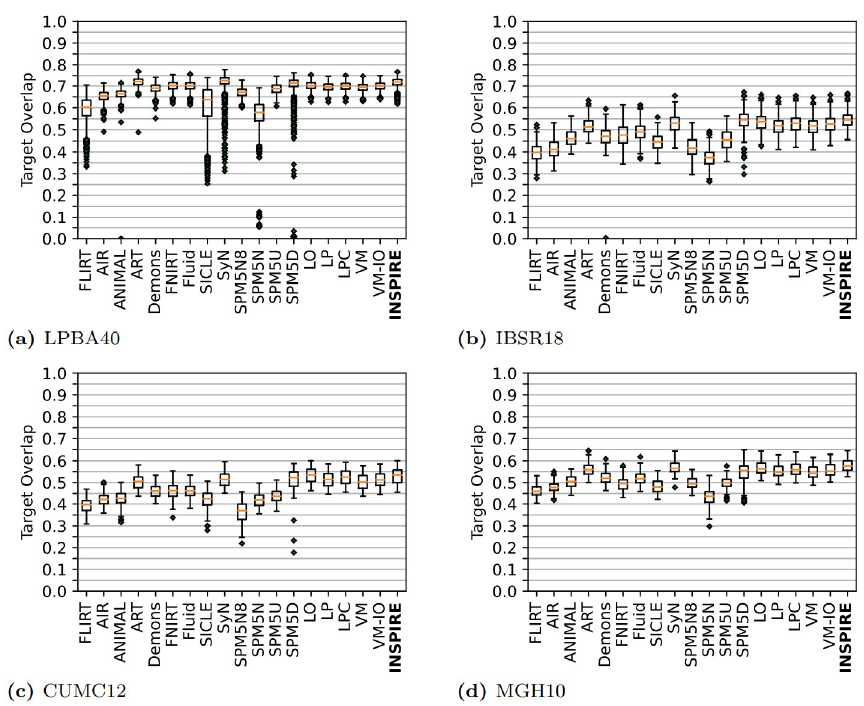
Fig 7. Target overlap (averaged over all labels) shown as box-and-whiskers plots for the four MR datasets. A higher score is better. The center line of the box marks the median, bottom and top mark the first and third quartiles ( Q 1 , Q 3 ), and bottom and top of the whiskers mark the minimum and maximum (excluding outliers beyond Q 1 − 1.5 ( Q 3 − Q 1 ), and Q 3 + 1.5( Q 3 − Q 1 ), which are shown as diamond markers). The proposed method, INSPIRE, is bolded. See [14] for details of the experiment protocol and the compared